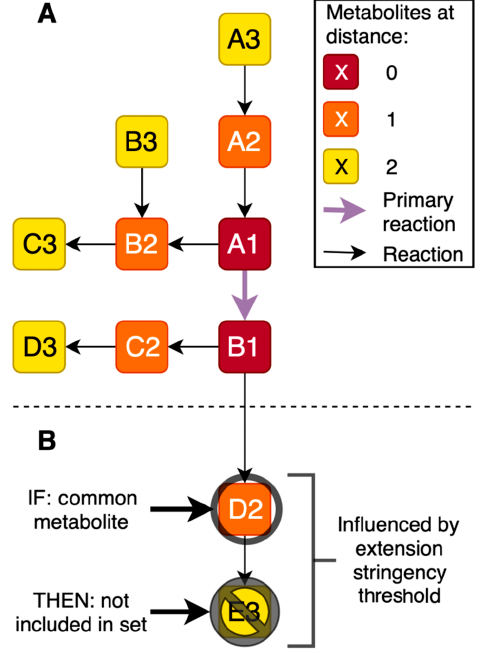
Figure 7. Metabolite set extension. ( A,B ) Reactions are depicted by black arrows, metabolites